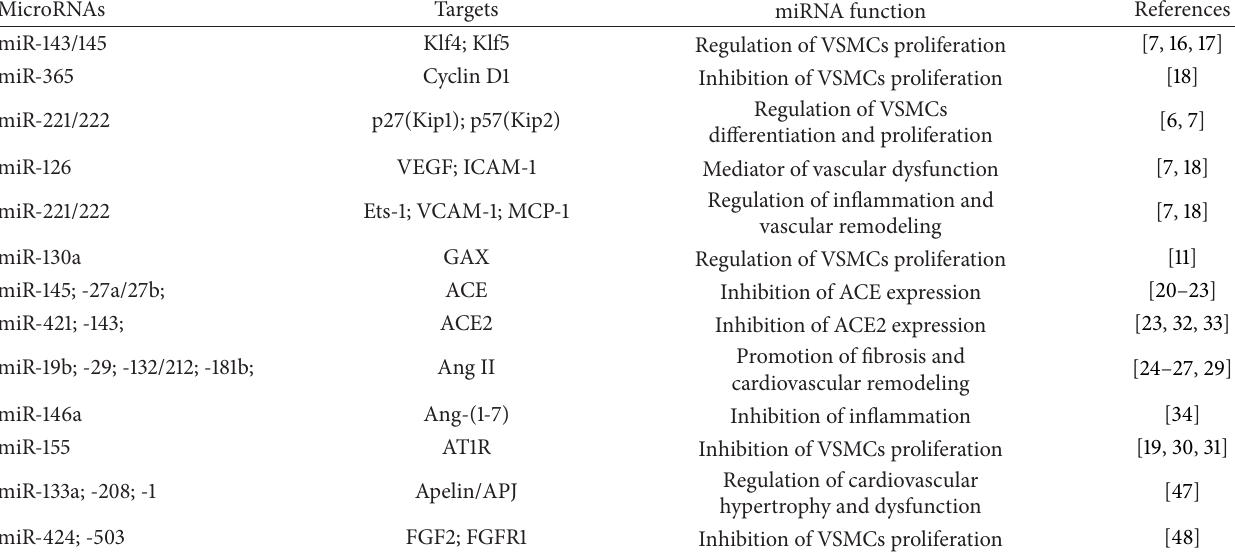
Table 1: The RAAS, Apelin/APJ signaling, and microRNAs in